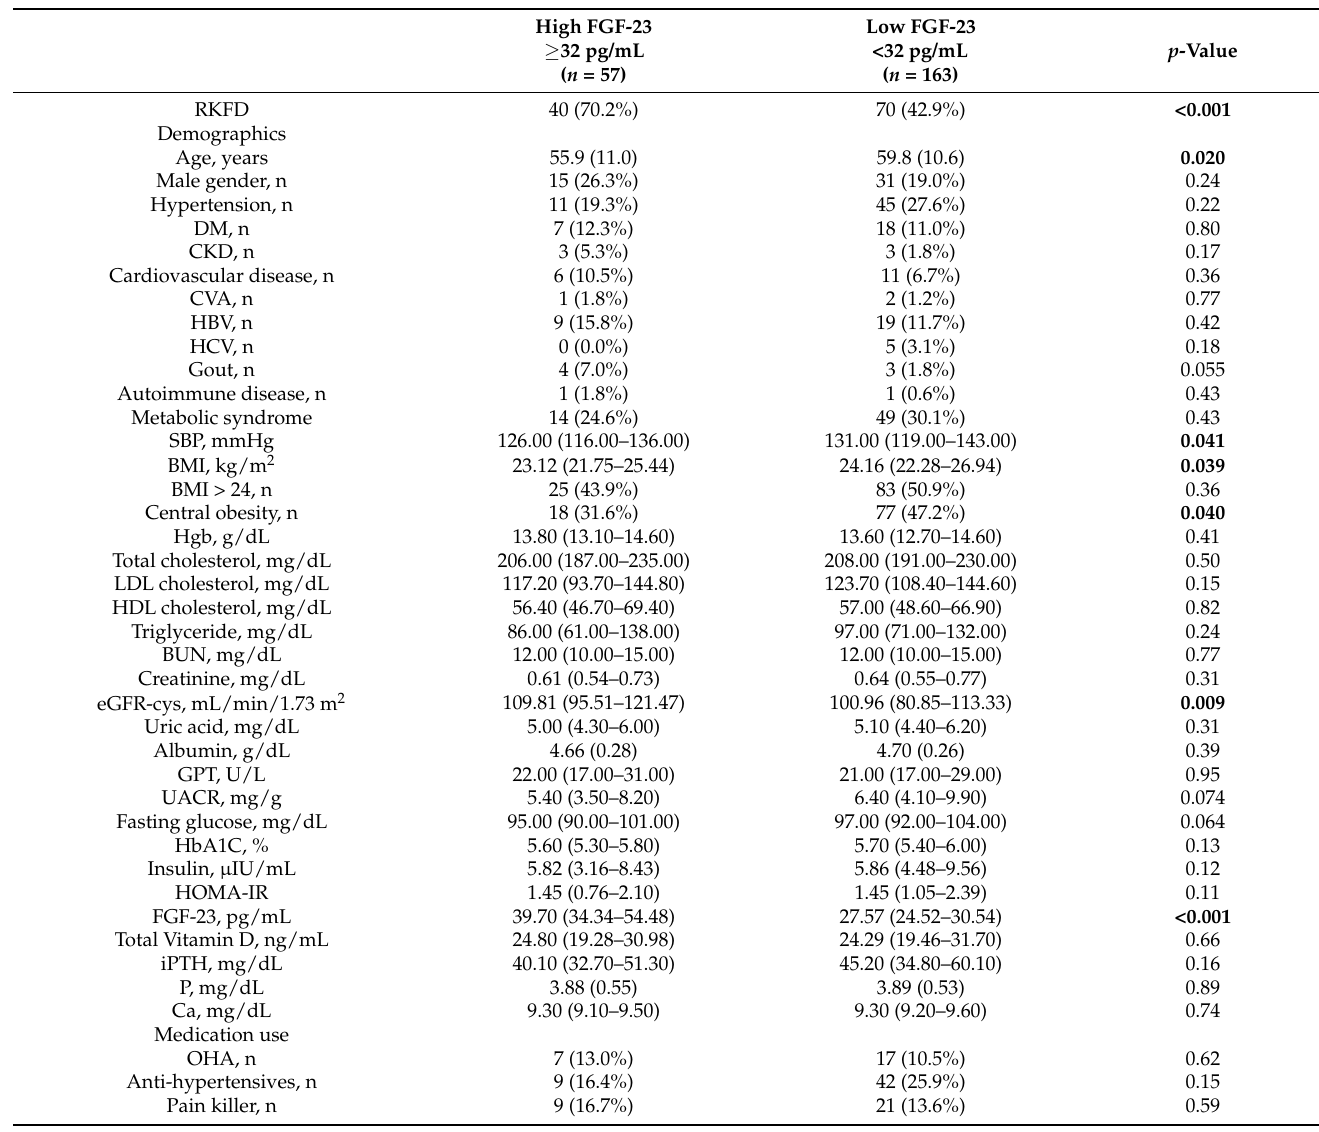
Table 3. Demographic characteristics of enrolled subjects stratified by cut-off values of FGF-23 and 32